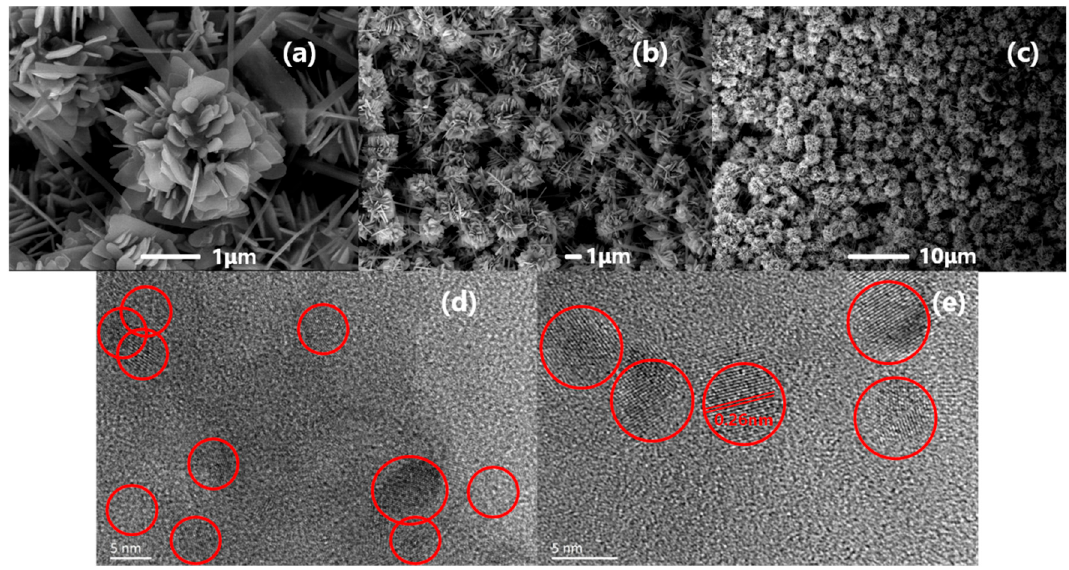
Figure 3. ( a – c ) Representative SEM images of the ZnO microspheres; ( d , e ) TEM images of the CQDs.